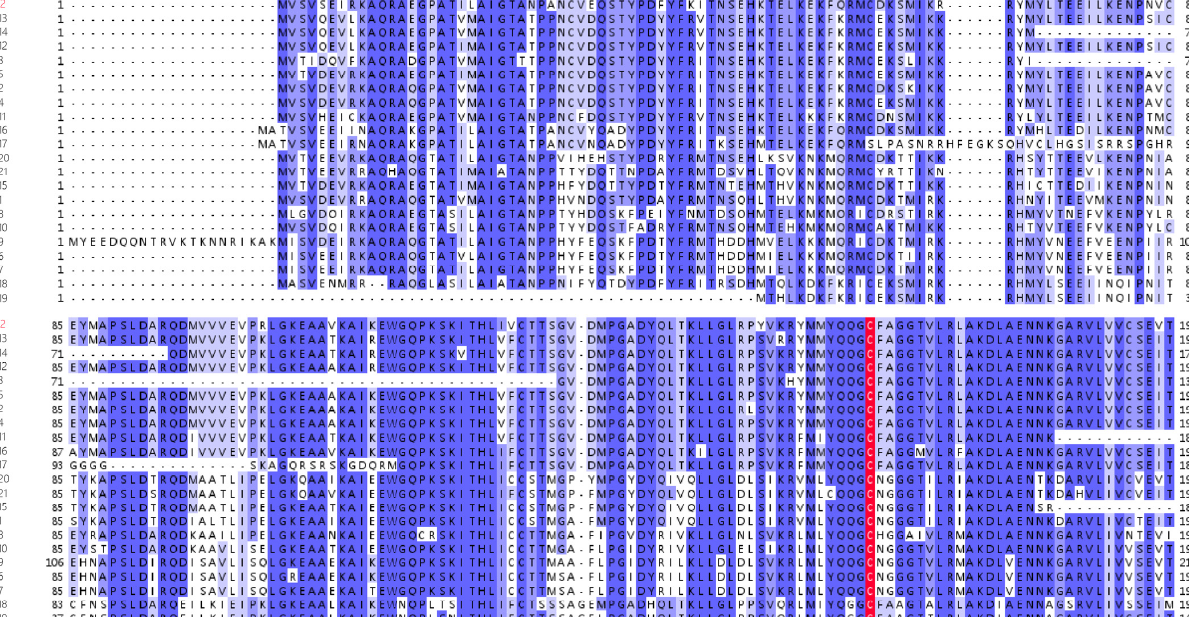
Figure 1. Multiple sequence alignment of the deduced peptides of MiCHS, together with MsCHS2 (P30074), from Medicago sativa . The CHS/STS signature motifs (WGVLFGFGPGLT) are framed by an orange box. The active site Cys-His-Asn triad and Phe based on MsCHS2 are highlighted in red and purple, respectively. The darker blue indicates higher numbers of identical residues. Gaps are represented by short hyphens. 3.3. Construction of the Phylogenetic Tree, Motif Pattern, Domain and Gene Structure A maximum likelihood tree was constructed, along with the motif pattern, domain information and gene structure, for further phylogenetic analysis using the amino acid sequences of the putative MiCHS proteins (Figure 2). The MiCHSs were classified into